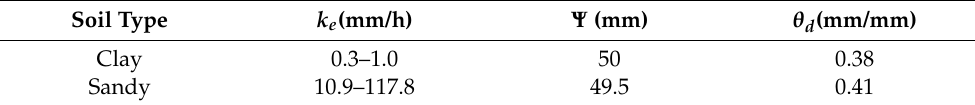
Table 1. Green-Ampt parameters values used [48,55].